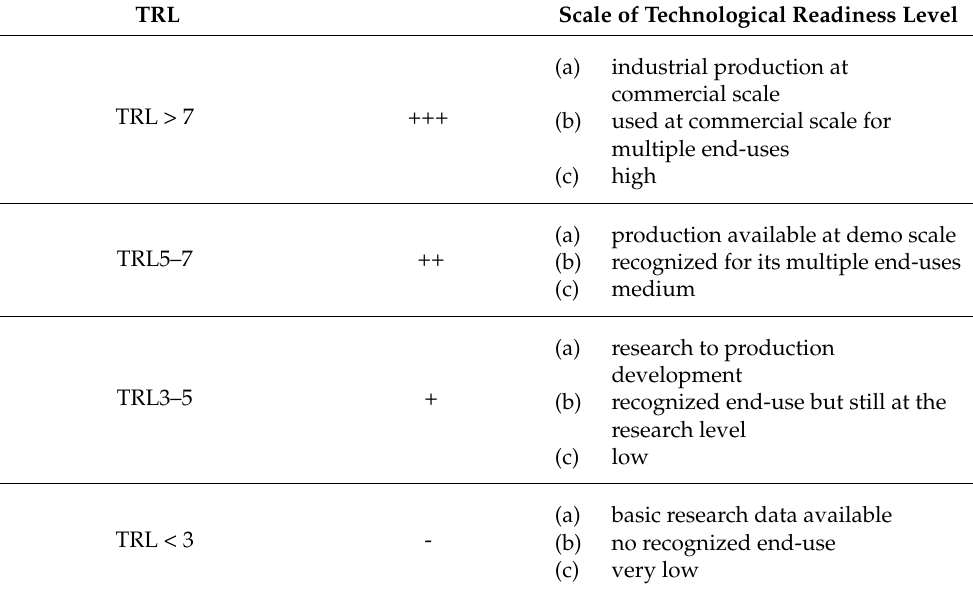
Table 2. Technology readiness level (TRL) for the criteria used in assessing strengths for non-food biomass